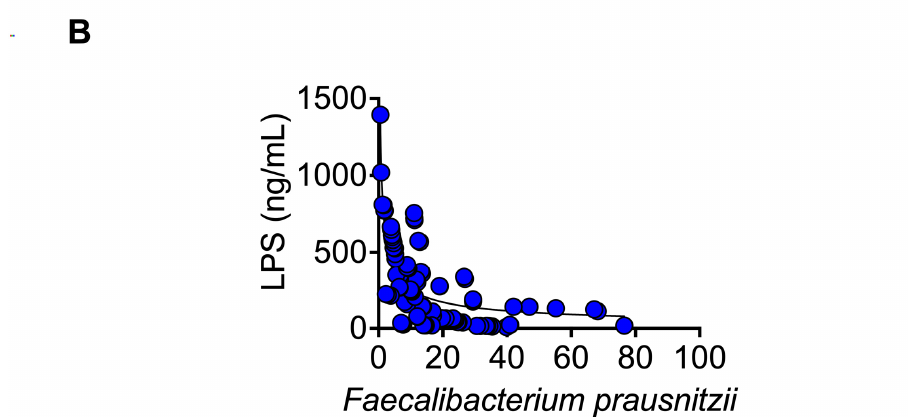
Figure 7. Analysis of multiple correlations between variables measured in the study ( A ). Correlation analysis between the serum concentration of LPS and the abundance of Faecalibacterium prausnitzii ( B ). Statistical significance was assessed by Spearman r. p < 0.05.